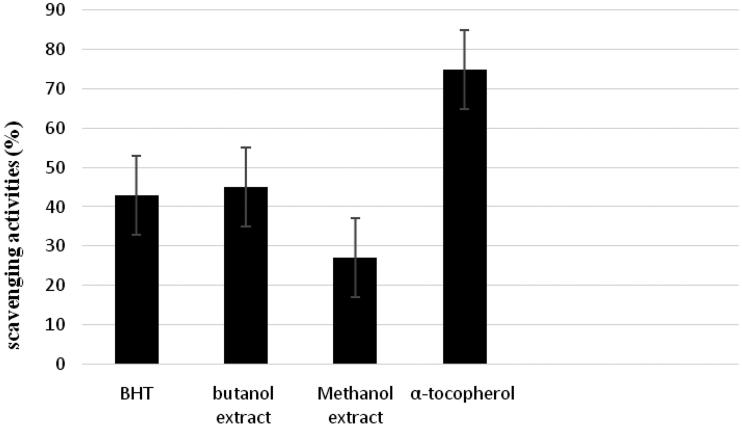
Hydrogen peroxide scavenging activity of MeOH and n-BuOH extracts
of V. nubicum, α-tocopherol and BHT at 100 μg/mL concentration.